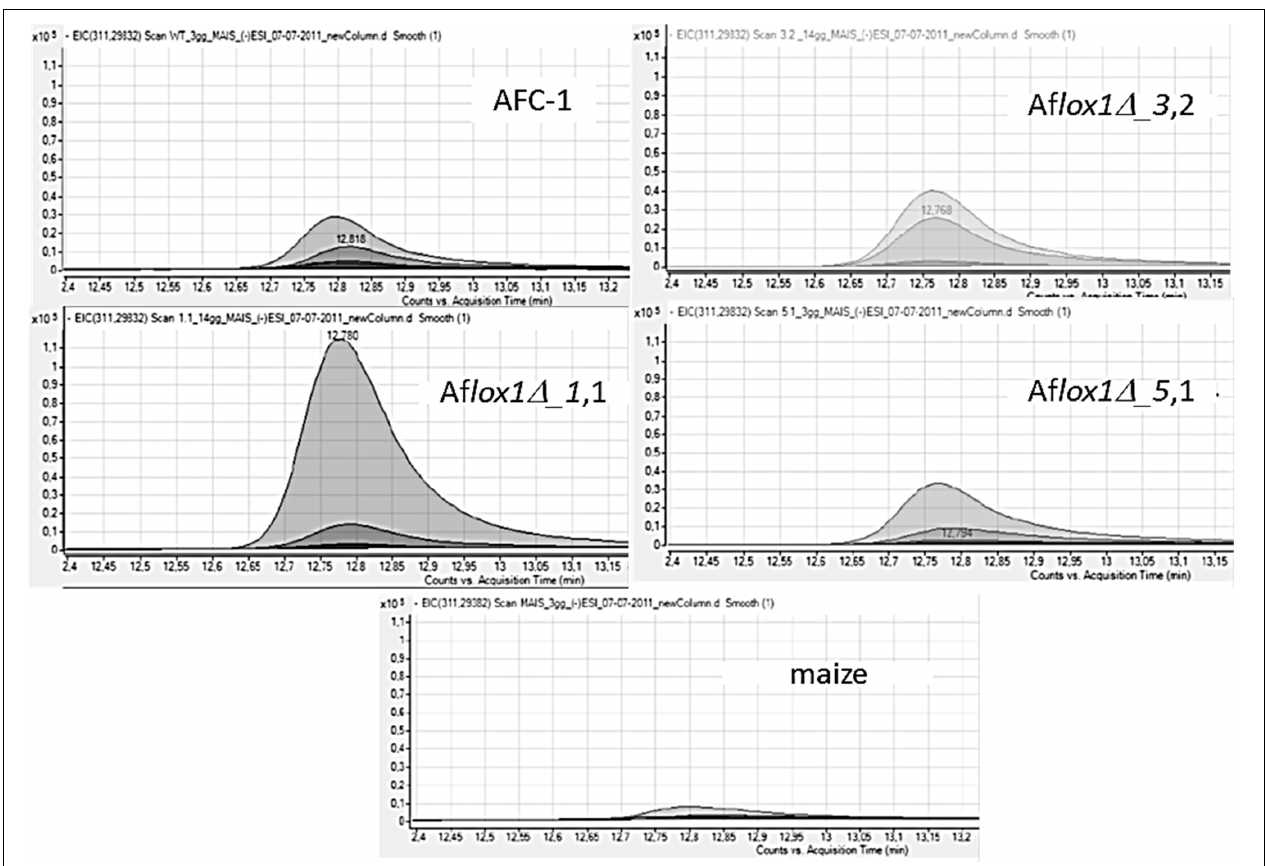
FIGURE 8 | Chromatogram (of the lipid compound at 311.2983m/z corresponding to HPODE) in overlap mode deriving by LC-TOF analysis of lipid extract of maize kernels non-inoculated or inoculated with AFC-1 and the 3 deleted Af lox1 strains (1.1/3.2/5.1) at 3, 7 and 14dpi.